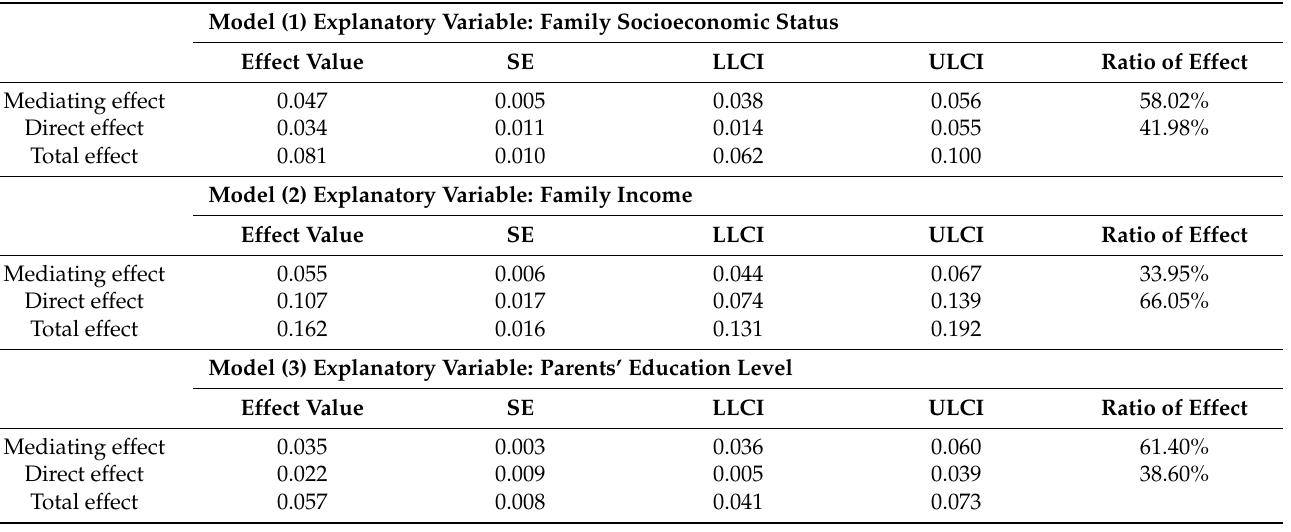
Table 8. Mediating effect Test Table of parent-child interaction